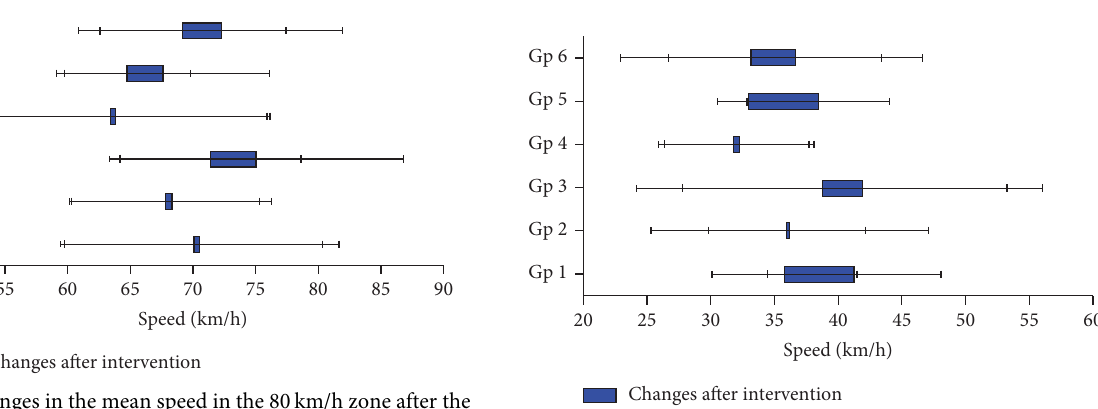
Figure 8: Changes in the mean speed at the intersection after the intervention (the error bars represent the standard